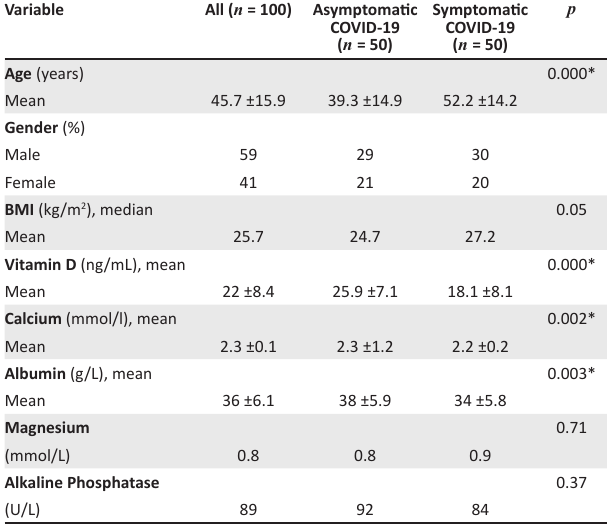
TABLE 2: Differences between symptomatic and asymptomatic